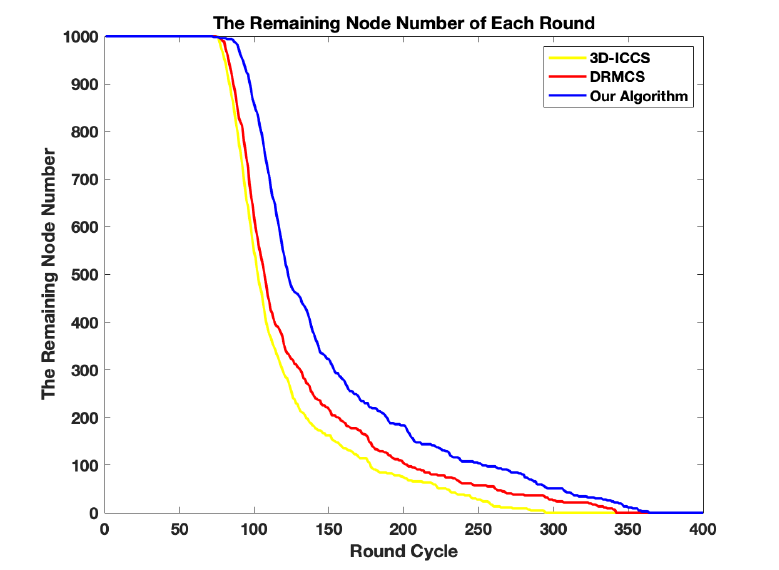
Figure 9. The comparison results in terms of remaining living